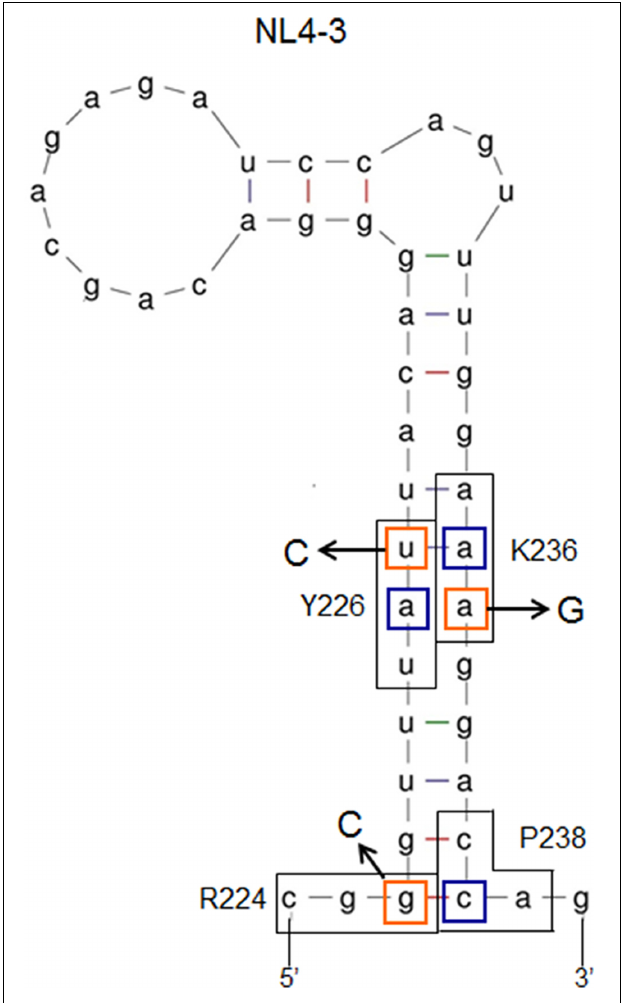
FIGURE 8 | Secondary RNA structure of HIV-1 NL4-3 SLSA1. Secondary RNA structure of NL4-3 SLSA1 was predicted by mfold program (Zuker, 2003). In the structure, amino acid sites R224/Y226/K236/P238 of NL4-3 Pol-integrase, the corresponding codons (black-boxed), nucleotide sites analyzed (orange-boxed), and the complementary mutations (blue-boxed) are shown. Nucleotide substitutions are also shown by arrows. FIGURE 9 | Predicted secondary RNA structures of SLSA1 structural